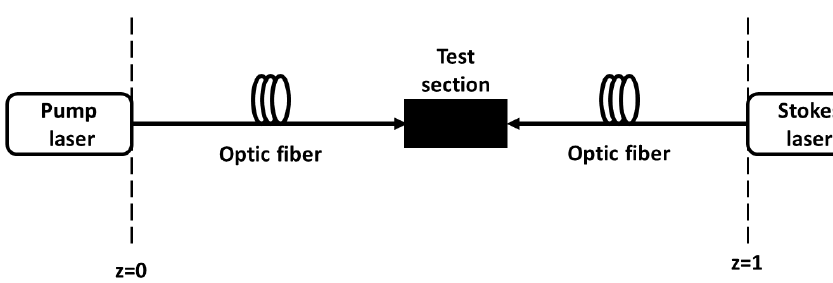
Figure 5. Basic measurement principle of BOFDA.